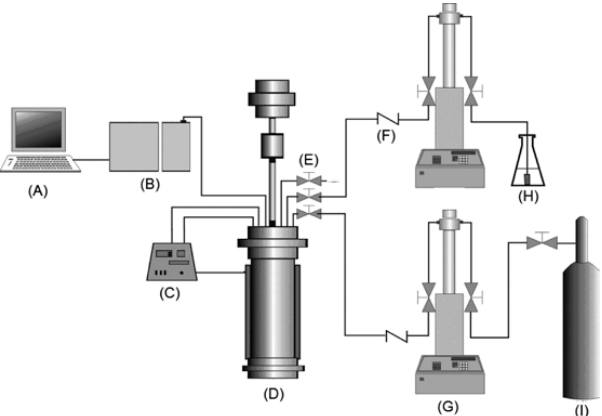
Figure 3. Schematic representation of the experimental set-up for the synthesis of materials in scCO 2 : ( A ) computer; ( B ) online GC-MS; ( C ) temperature and RPM controller with pressure display; ( D ) 100-mL autoclave equipped with a diamond FTIR probe; ( E ) needle valves; ( F ) check valves; ( G ) syringe pump; ( H ) supply for liquid reactants/solvents, and ( I ) CO 2 cylinder. (Reprinted with permission from [36]. Copyright American Chemical Society, 2009).